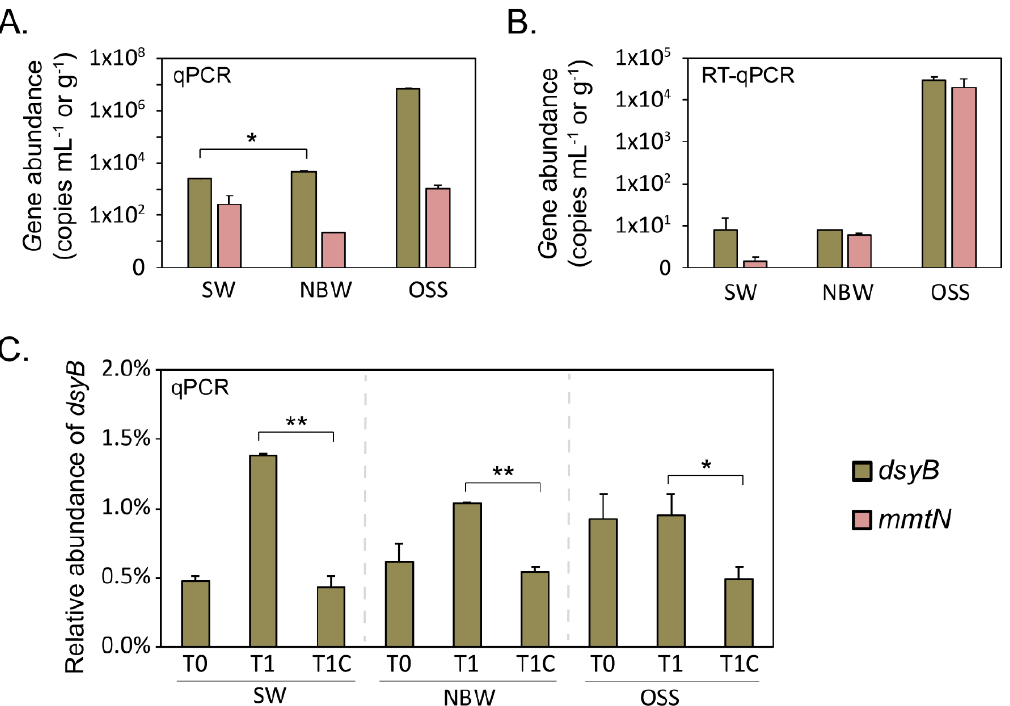
Figure 2. qPCR data on the abundance and transcription of dsyB and mmtN in P03 samples. ( A ) dsyB and mmtN gene abundance in P03 SW (surface water), NBW (near bottom water) and OSS (oxic surface sediment) samples. ( B ) dsyB and mmtN gene transcript abundance in P03 SW, BW and OSS samples. ( C ) Relative abundance of dsyB normalized to the abundance of 16s rRNA gene in natural P03 (T0), enriched (T1) and control incubation experiments after 14 days. Data were obtained on two or three independent samples ( n = 2 or n = 3). Error bars represent standard deviation from the mean value. * p < 0.05 in Student’s t -test. ** p < 0.005 in Student’s t